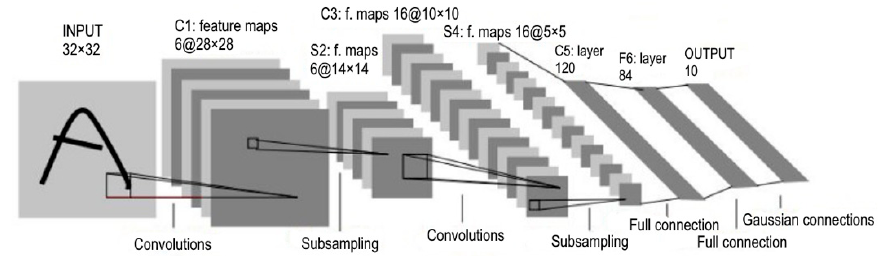
Figure 9. Example architecture of a convolutional network [36].